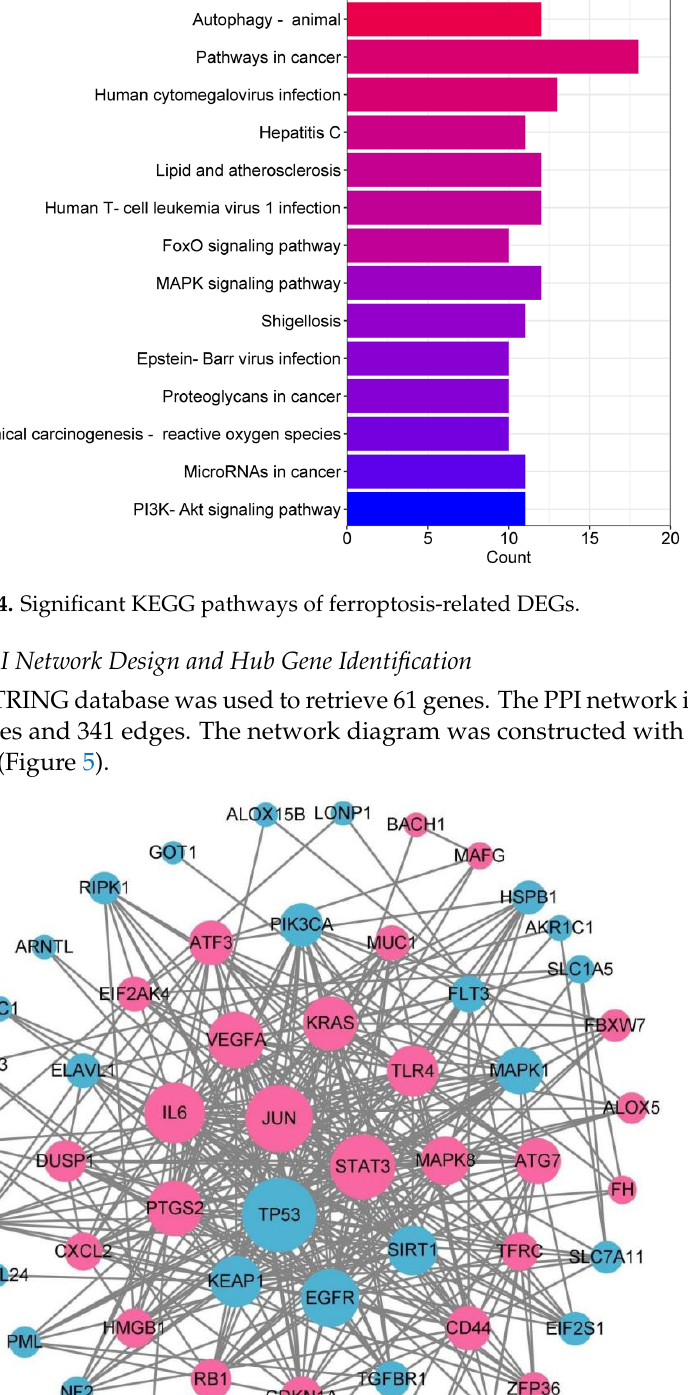
Figure 6. PPI network created using additional DEGs and 10 hub genes. The weight of a hub gene across the network increases with the hue of the gene. 3.4. Validation of Hub Genes